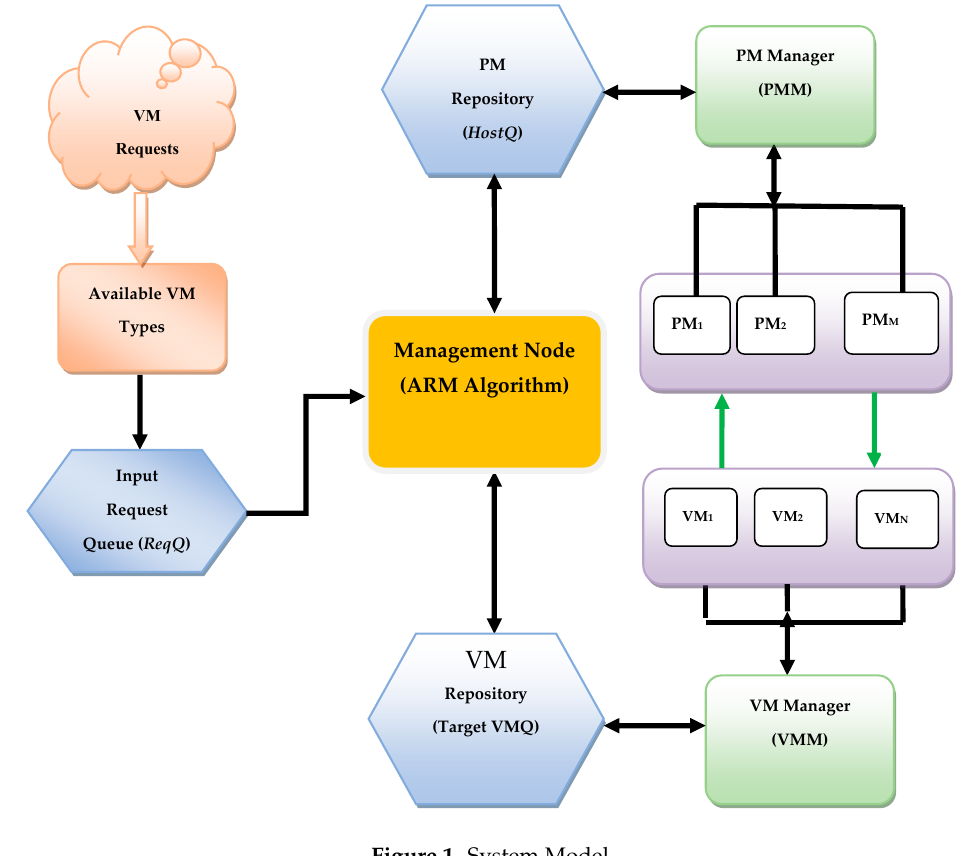
Figure 1. System Figure 1. System Model.